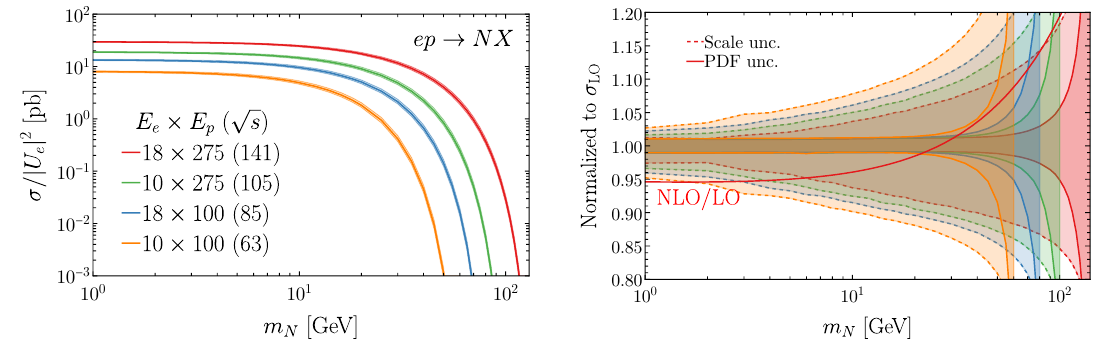
Figure 1 . Left: the HNL production cross sections divided by the squared mixing parameter | U e | 2 at the EIC with unpolarized beam energies as E p × E e [ GeV 2 ] ( HNL mass. Right: the scale and PDF error bands for the HNL cross section at the EIC, estimated with CT18NNLO PDFs and varying renormalization and factorization scales by a factor of 2. The red solid line indicates the NLO/LO cross section ratio for the representative